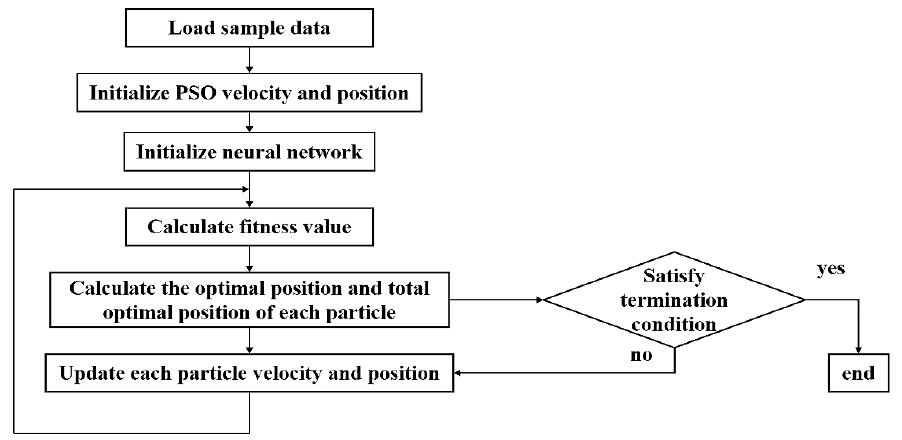
Figure 7. Algorithm flow of PSO neural network.